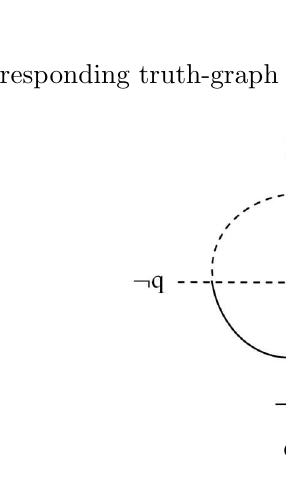
Schema 7 stands for a two-place basic formula: ⌊ p q ⌋ (pq), while graph 24 (also see graph 12 (a)) stands for an assertion: ⊢ p ↔ q. Schema 6 and graph 24 all show that an expression is true iff both ‘p’ and ‘q’ is true (have value 1), or both ‘p’ and ‘q’ is false (have value